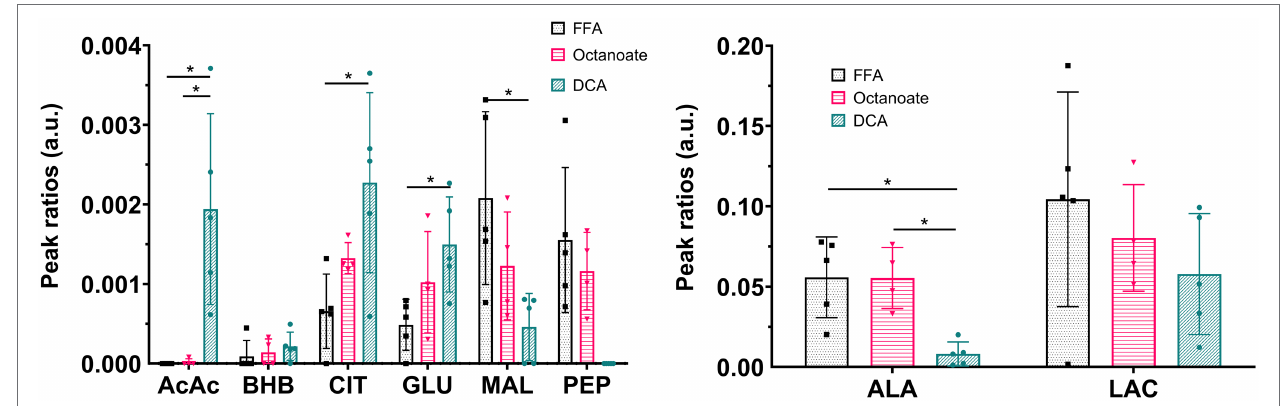
FIGURE 2 | Ratios of signal intensities of individual resonances to sum of all 13 C resonances in the spectrum. Pyruvate-hydrate resonance was excluded from total 13 C intensities sum. *Indicates statistical significance ( p < 0.05; see section Materials and Methods). AcAc sum includes signal intensities at both C-1 and C-3 chemical shifts. AcAc, acetoacetate; AcCar, acetyl carnitine; ALA, alanine; BHB, 3-hydroxy butyrate; CIT, citrate; GLU, glutamate; MAL, malate; LAC, lactate; PEP, phosphoenolpyruvate; and PYR, pyruvate. n = 5 (DCA), 4 (Octanoate), and 5 (FFA).